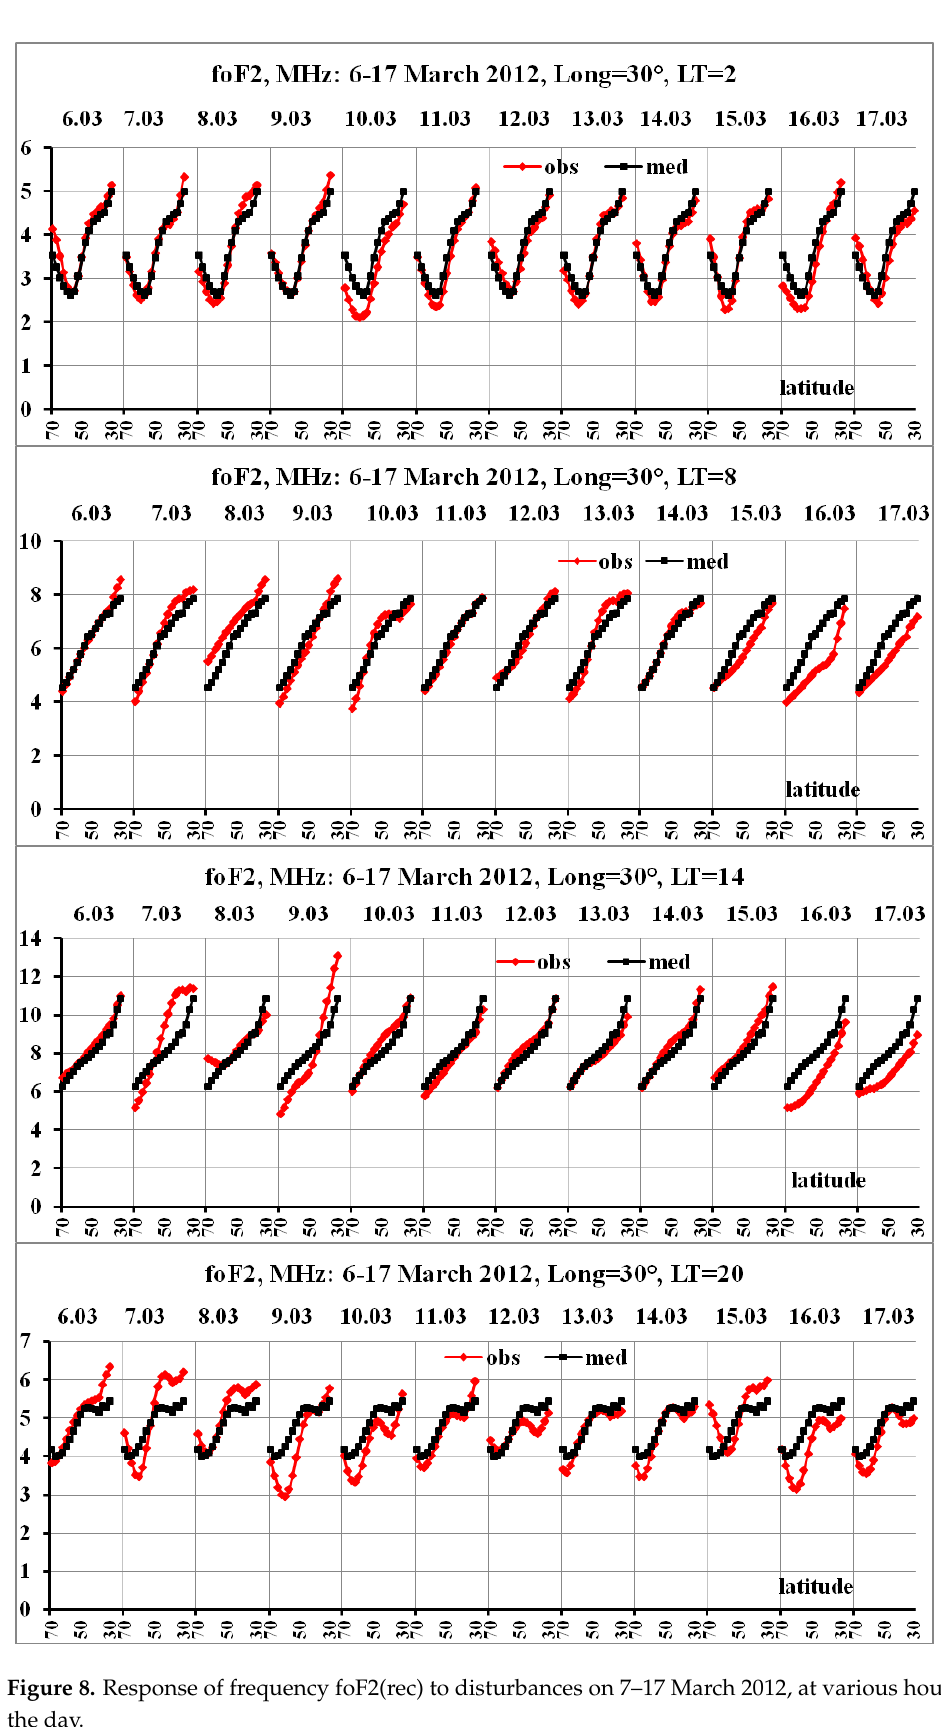
Figure 8. Response of frequency fo F2(rec) to disturbances on March 7-17, 2012, at various hours of the day.